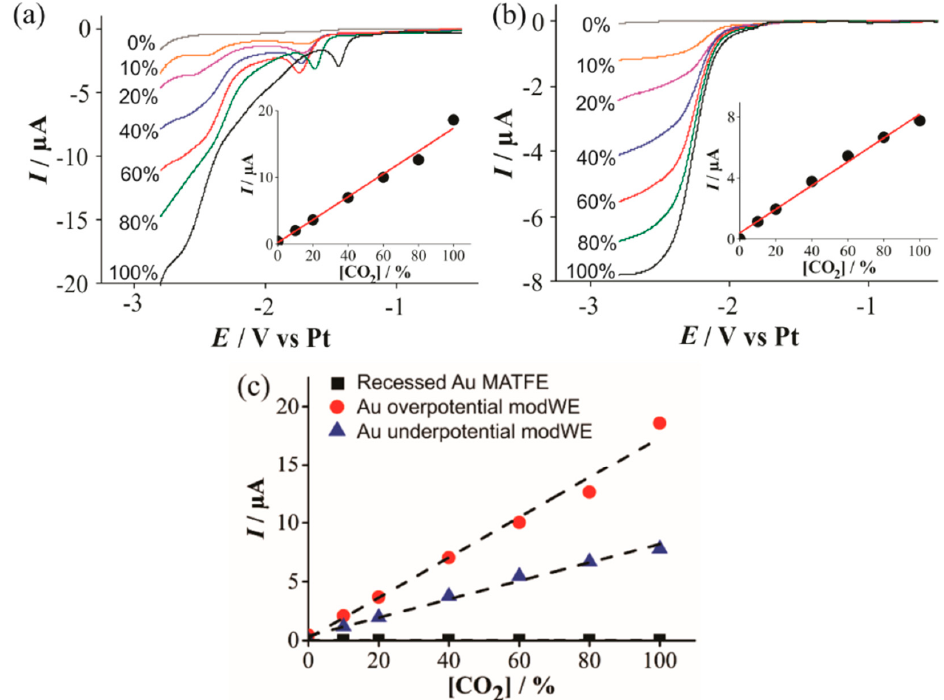
Figure 7. Linear sweep voltammetry (LSV) for the reduction of CO 2 (10%–100% vol.) in [C 4 mpyrr] [NTf 2 ] on a ( a ) Cu overpotential modWE and ( b ) Cu underpotential modWE at a scan rate of 100 mVs − 1 . Grey line is the response in the absence of CO 2 . The insets show background-subtracted calibration plots of peak current vs. concentration along with the line of best fit. These calibration plots are overlaid in ( c ), showing the response on a recessed Pt MATFE ( (cid:4) ), Cu overpotential modWE ( (cid:8) ), and Cu underpotential modWE ( (cid:78) ). Due to the absence of a clear peak, currents were measured at a potential of − 2.7